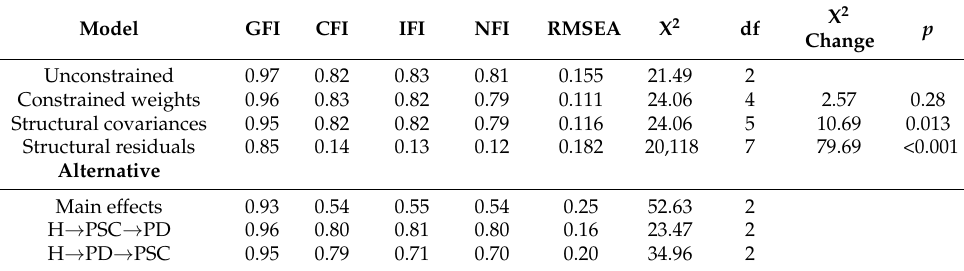
Table 5. Fit measures.